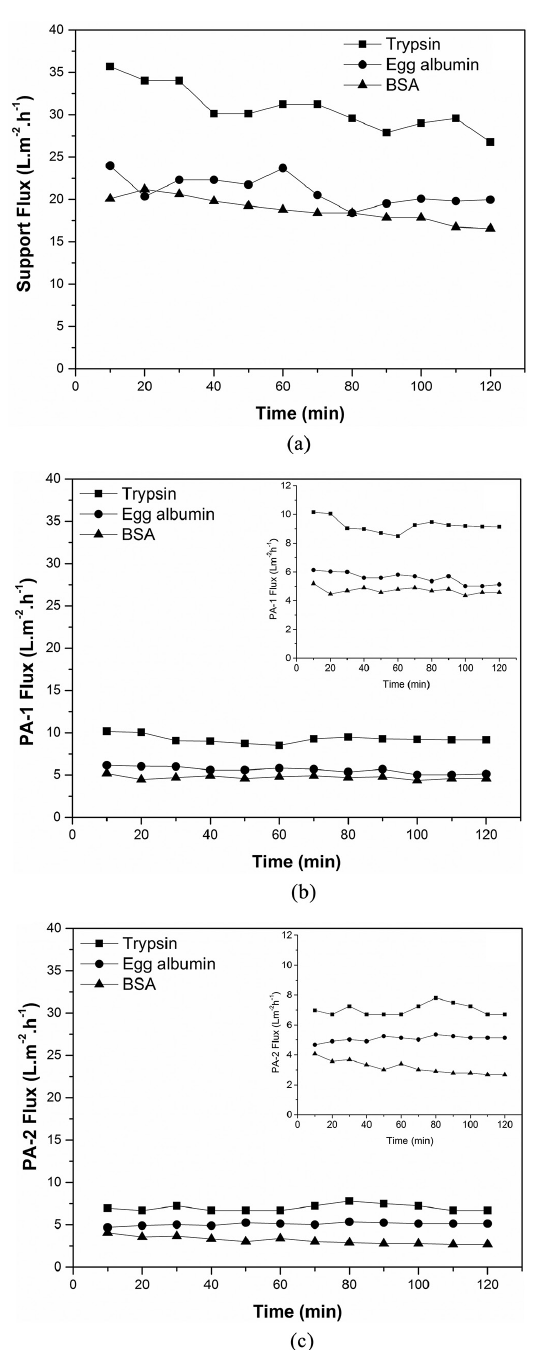
Figure 6. Protein permeate flux of the support (a) and composite membranes PA-1 (b) and PA-2